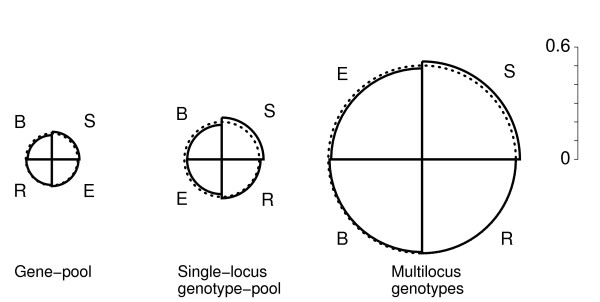
Differentiation snails at three levels of genetic integration in four oak stands. For six microsatellite loci scored in four stands of oak (R, B, S, E) the differentiation snails were constructed from the snail components Δj in Tab. 1. Dotted circles mark the symmetric population differentiation ΔSD. Within each snail, the quantitative differences among the components are slight. Each snail differs qualitatively in the ranking of the stands from the other two (i.e., covariation C < 1 for each comparison). The significantly large increase in the radius ΔSD of the snails with each higher integration level confirms the differentiation among the stands for form of gene association.